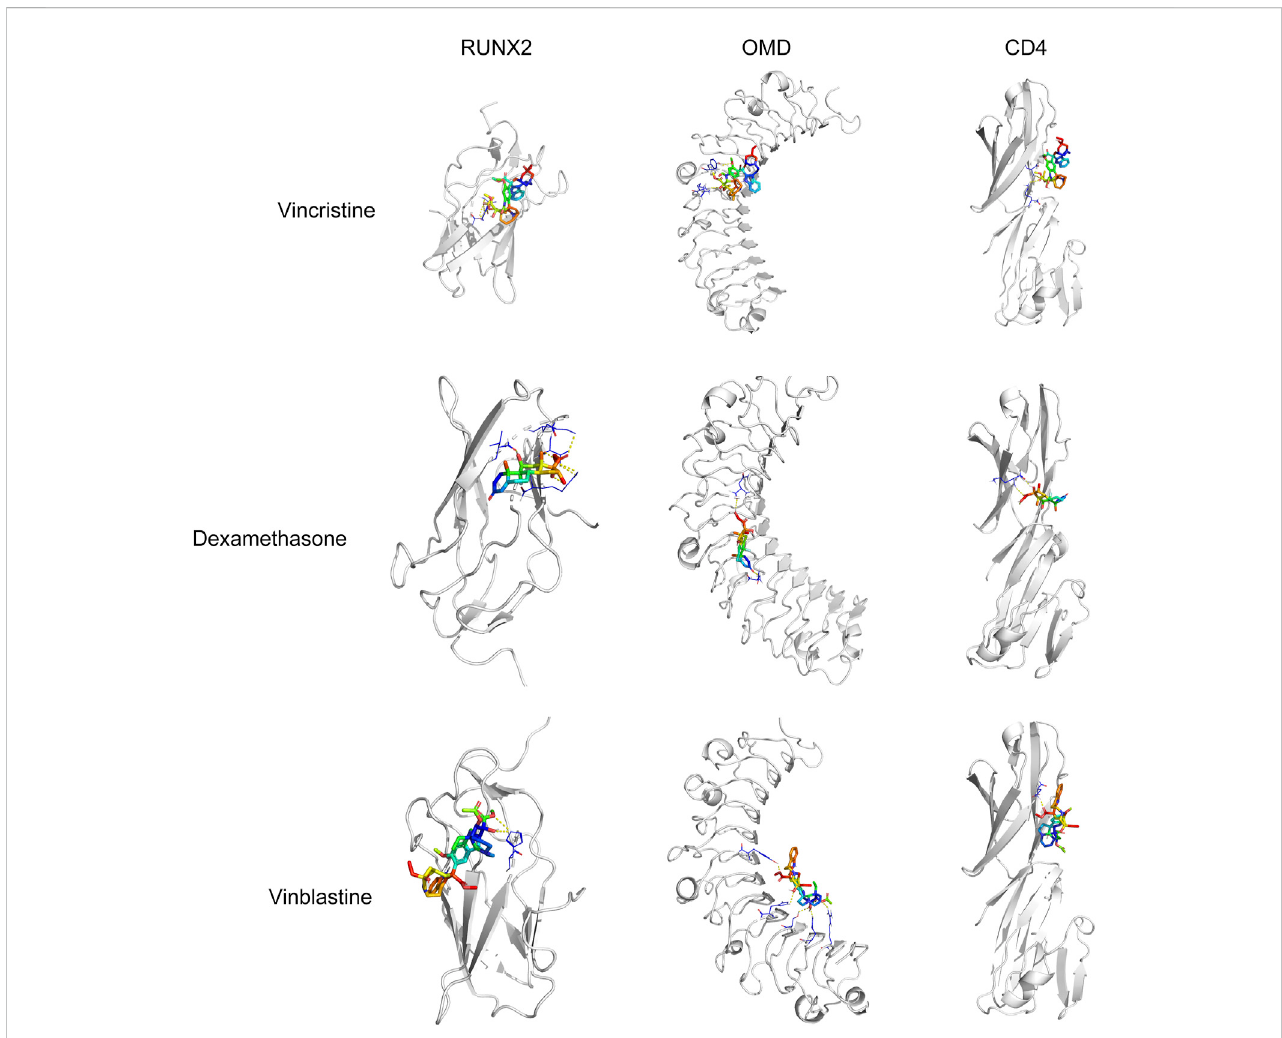
FIGURE 8 Molecular docking analysis of vincristine, dexamethasone, and vinblastine with RUNX2, OMD, and CD4.